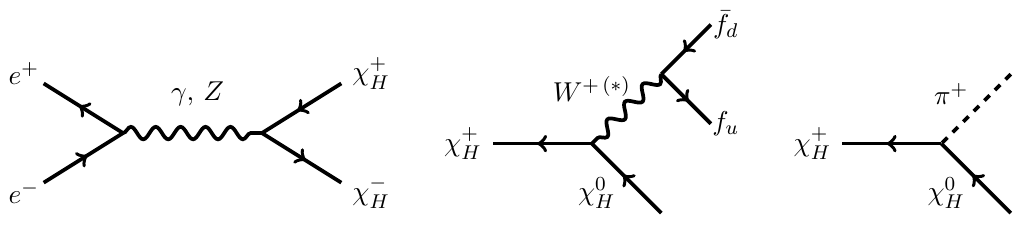
Figure 3 . Feynman diagrams for charged higgsino pair production at LEP (left) and charged higgsinos decays (center and right). f u ; f d stand for Standard Model up or down type quarks or leptons. Both the cross section and branching ratios are (cid:12)xed by the higgsino’s quantum numbers and the chargino and neutralino